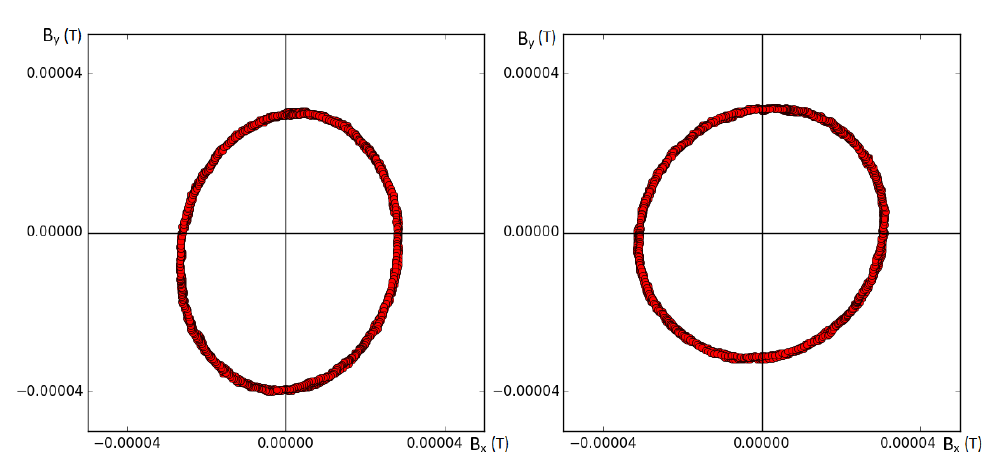
Figure 14. Magnetic field measurements before ( left ) and after calibration ( right ).